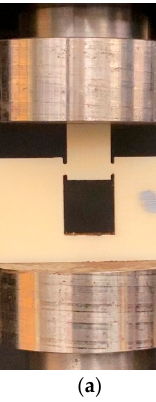
Figure 4. Vertical sample of Flat Hat-Shaped specimen at ( a ) no load condition and the ( b ) shear- deformed